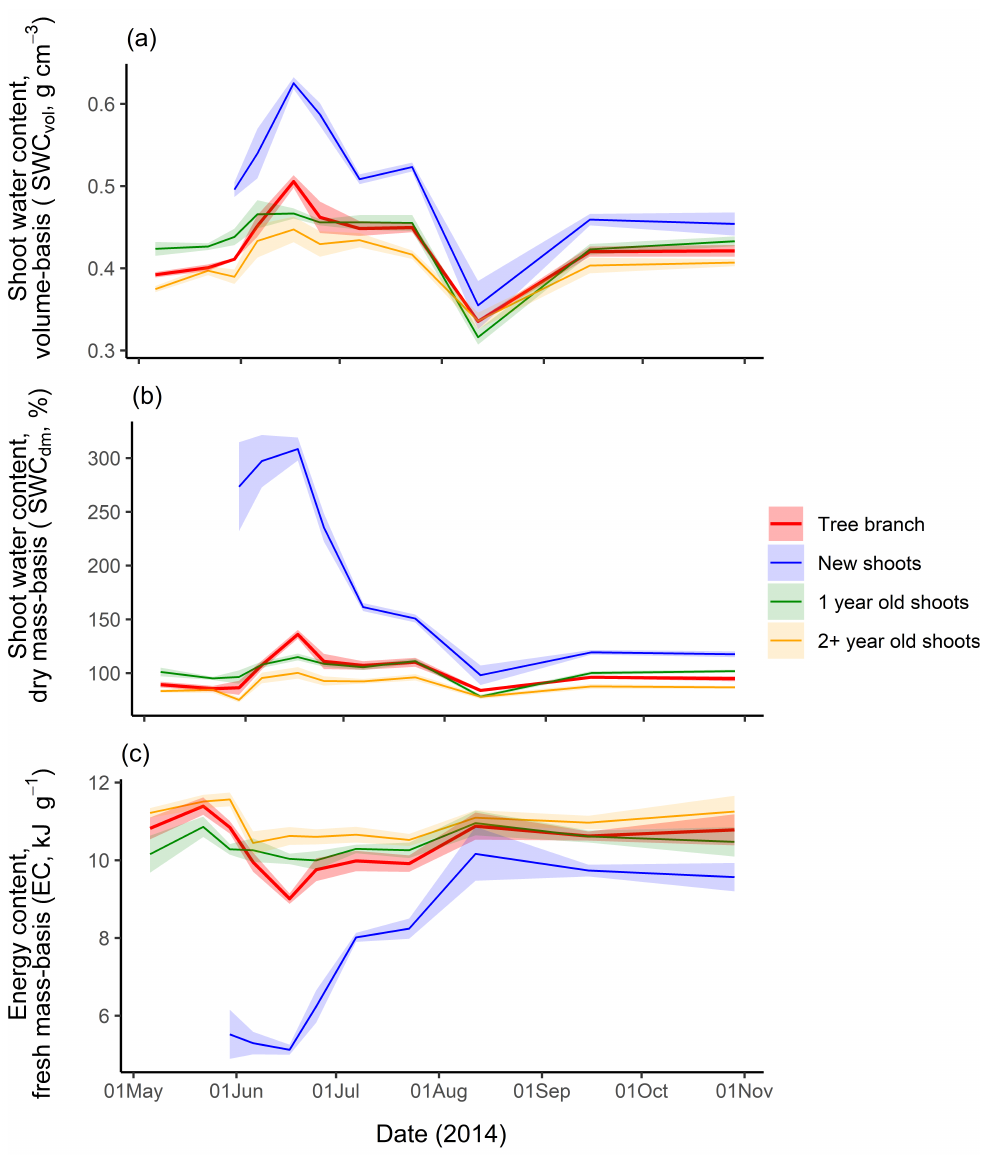
Figure 6. Seasonal variation in shoot properties for white spruce in 2014: ( a ) shoot water content on a volume basis (SWC vol ); ( b ) shoot water content on a dry mass basis (SWC dm ); and ( c ) fresh mass basis energy content (EC). Solid red, blue, green, and orange lines represent tree branch, new, 1 year-, and 2+ year-old shoots, respectively. Standard error is shown as a same-color shadow around each